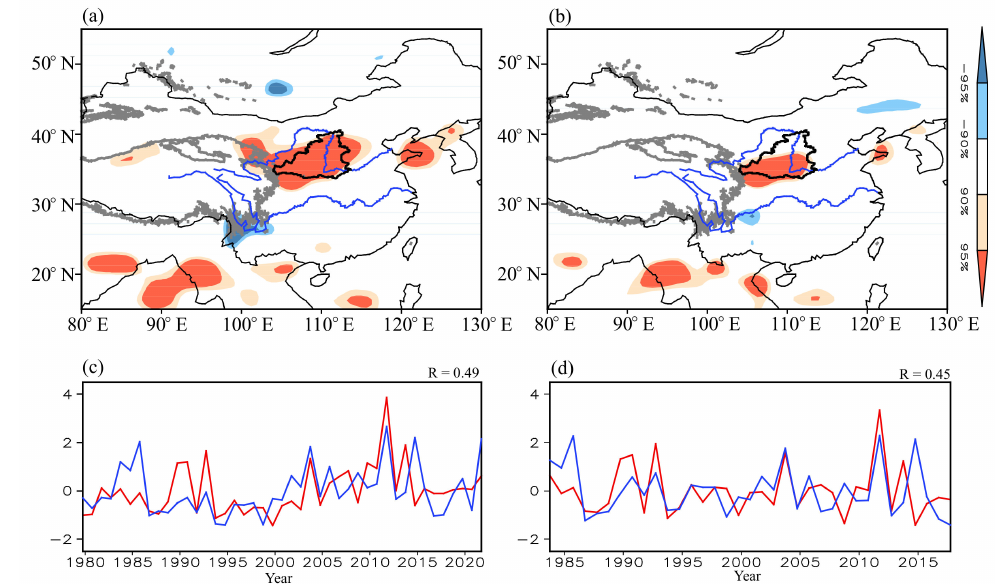
Figure 4. ( a ) Distribution of correlation coefficients between the July–August YGP SM index and September precipitation during the period 1979–2021; ( b ) As in ( a ), but for that on interannual time scales. Shadings denote the correlation significant at the 90% and 95% confidence levels, as shown by the color bars. The black bold borderline around the Yellow River (the blue curve in northern China) represents the MRYR region and the thick gray contour denotes the Tibetan Plateau (3000 m above sea level); ( c ) Standardized time series of the September observational MRYR precipitation index (blue line) and the July–August YGP SM index (red line) during the period 1979–2021; ( d ) As in ( c ), but for those on interannual time